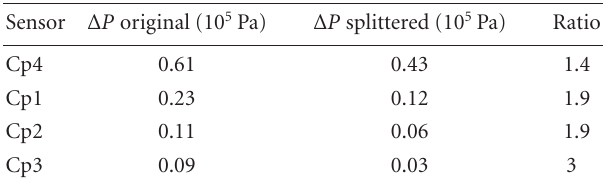
Table 5: Pressure fluctuations level ratio between original and split- tered